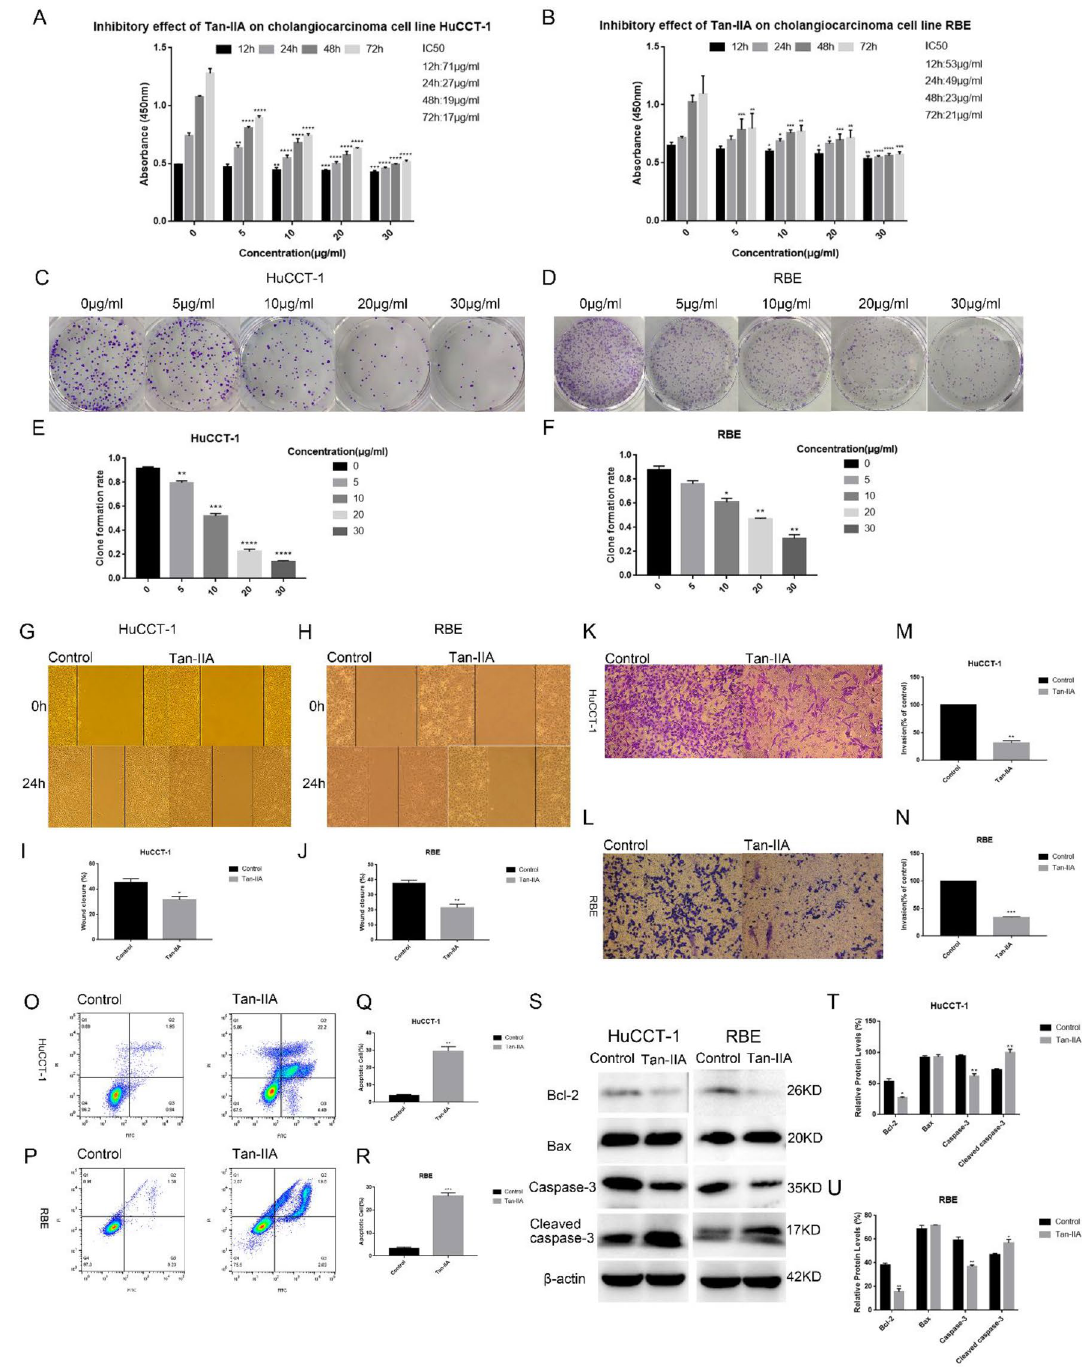
Figure 1. Cytotoxic effect of Tan-IIA on Cholangiocarcinoma cells. ( A , B ) Different concentrations (0, 5, 10, 20, and 30 µg/ml) of Tan-IIA were co-cultured with Cholangiocarcinoma cells for 12, 24, 48, and 72 h, and then the cytotoxic effect of Tan-IIA on Cholangiocarcinoma cells were detected by the CCK8 method. Cell viability histogram was made according to the formula (%) = [(experimental group OD value) − (blank group OD value)]/[(control group OD value) − (blank group OD value)] × 100%, and IC50 values were calculated for each time period. ( C – F ) Plate clone formation experiments were performed, Cholangiocarcinoma cells were co-cultured with Tan-IIA at concentrations of (0, 5, 10, 20, and 30 µg/mL) for two weeks and the number of clones was counted. Tan-IIA inhibits the migration and invasion of Cholangiocarcinoma cells. ( G – J ) Tan-IIA (24 h IC50 concentration) was co-cultured with Cholangiocarcinoma cells, then after scratching the cell layer for 24 h, cell migration by wound healing assay was determined. ( K – N ) The effect of Tan-IIA on the invasive ability of Cholangiocarcinoma cells was measured by the Transwell method. After crystalline violet staining, cell images were taken with an inverted microscope. Tan-IIA induced apoptosis of Cholangiocarcinoma cells. ( O – R ) The IC50 concentration for 24 h of Tan-IIA was selected and co-cultured with Cholangiocarcinoma cells for 24 h. Annexin V-FITC/PI double staining was used to detect apoptosis. ( S – U ) Western blotting to detect the effect of Tan-IIA on the expression of Bax, Bcl-2, as well as caspase-3 and cleaved caspase-3. Compared with control, * p < 0.05; ** p < 0.01; *** p < 0.001; **** p <